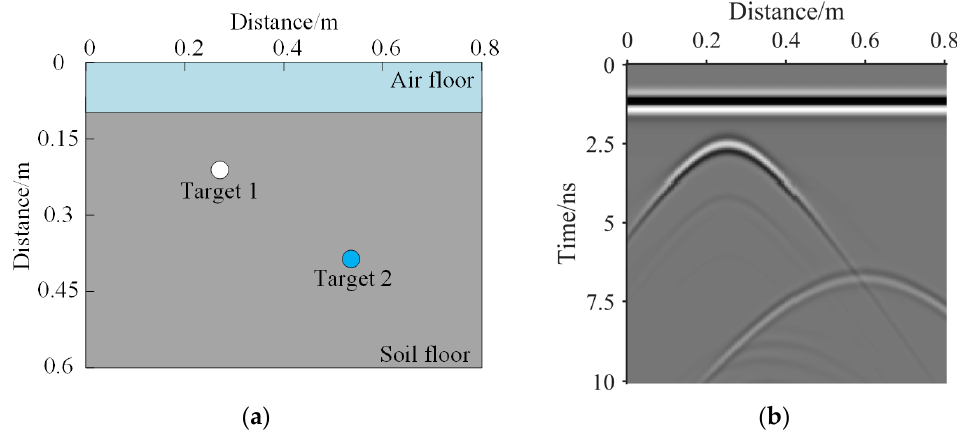
Figure 5. ( a ) GPRmax simulation model 1. ( b ) Simulated noise-free GPR image 1.